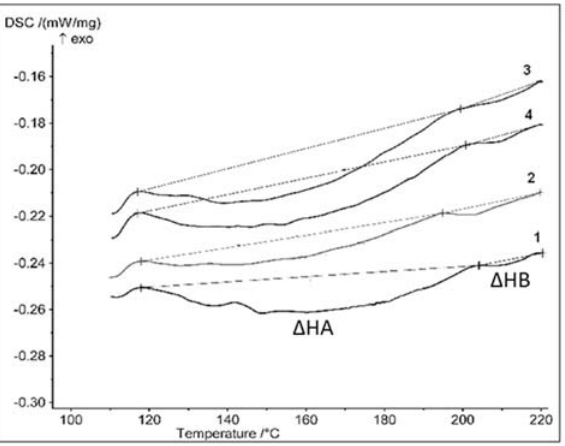
Figure 1. DSC thermograms for PVC R and PVC R /SiO 2 composites processed in rolling time of 1 min and 20 min: (1) PVC R 1 min; (2) PVC R 20 min; (3) PVC R /SiO 2 1 min; (4) PVC R /SiO 2 20 min. Table 1. Degree of gelation (%) of PVC R and PVC C and PVC nanocomposites with SiO 2 . Rolling Time, min